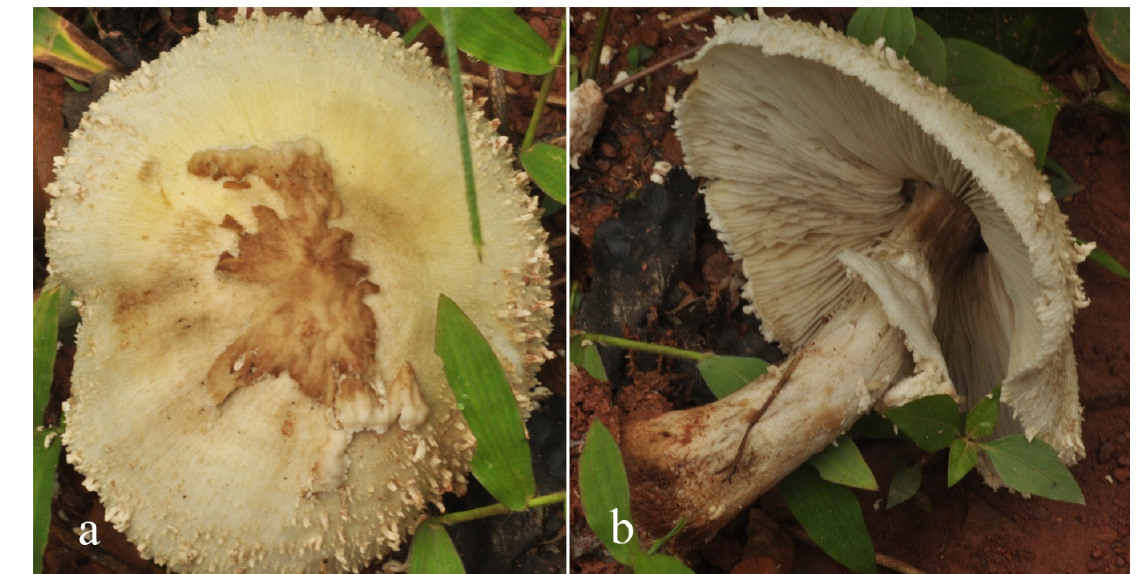
Figure 13. Fresh basidiomata of Clarkeinda trachodes in situ. ( a , b ) MFLU 19-2351.